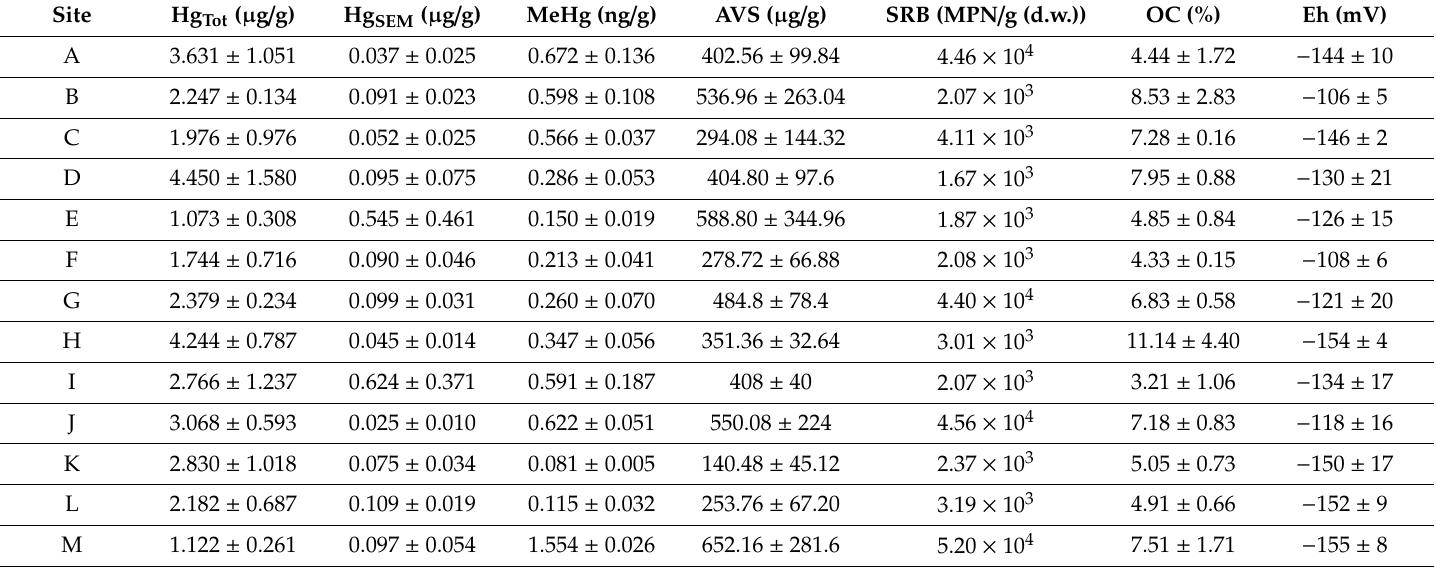
Table 2. Total mercury (Hg Tot ), simultaneously extracted mercury (Hg SEM ), methylmercury (MeHg) concentrations, acid-volatile sulfide (AVS) content, sulfate-reducing bacteria (SRB) amount, organic carbon (OC) content, and redox potential (Eh) in the sediment of each sampling